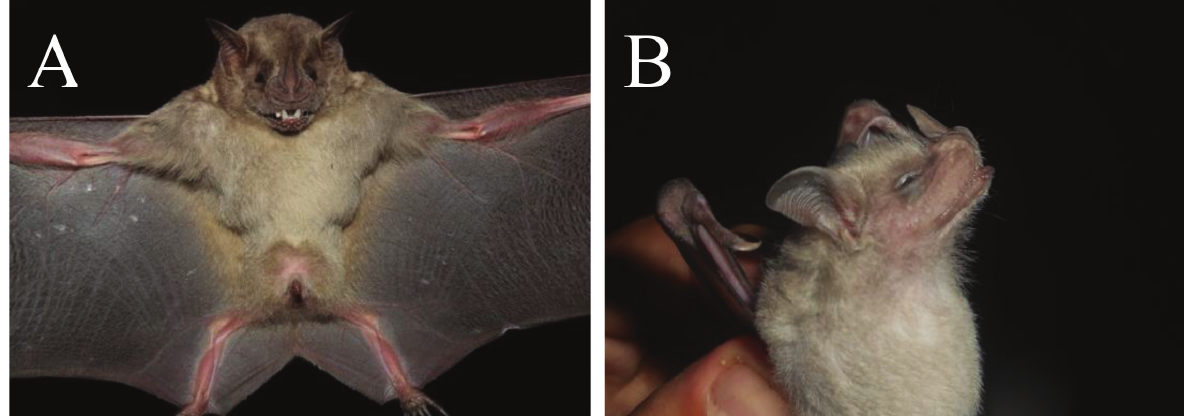
Figure 1. Artibeus inopinatus . A – Adult male captured in Carboneras, Sabanagrande in the department of Francisco Morazán (center of Honduras). B – Adult female captured in Nagarejo, Nacaome in the department of Valle (southern